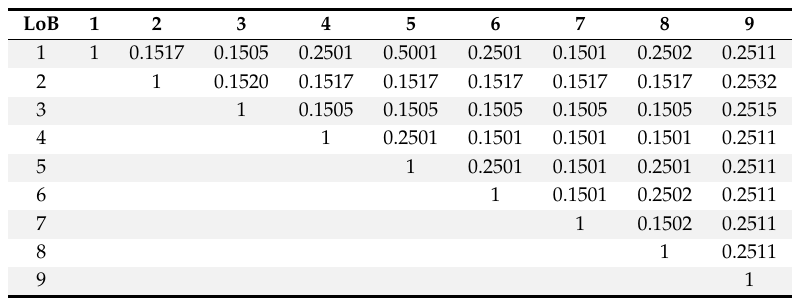
Table 7. Correlation block for the marginalized model: Ω PY .